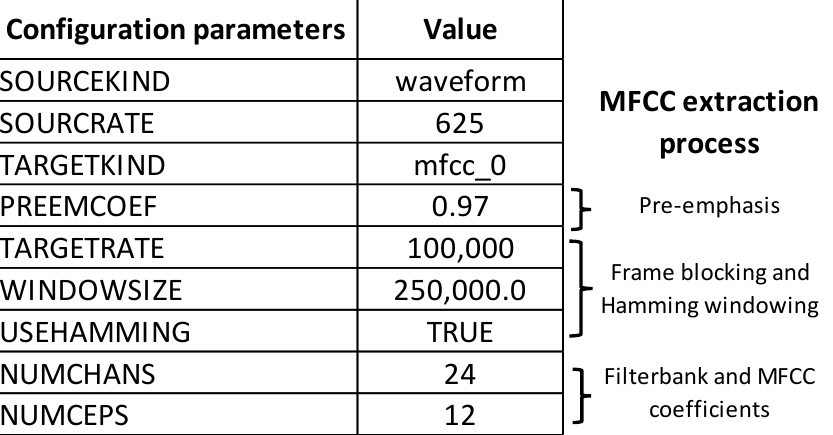
Figure 9. Configuration file parameters.